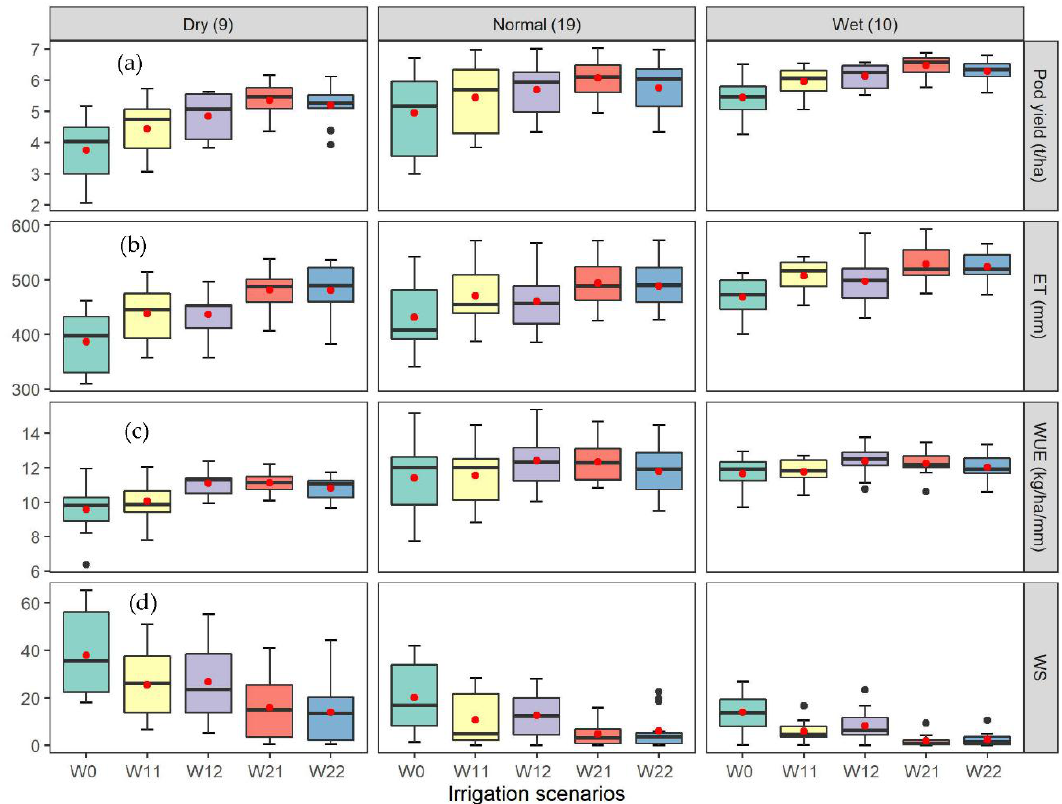
Figure 11. Simulated ranges of peanut ( a ) pod yield, ( b ) evapotranspiration (ET), ( c ) water use efficiency (WUE), and ( d ) water stress (WS) days under different irrigation scenarios, i.e., W0 (rainfed), W11 (60 mm depth before planting), W12 (60 mm depth at flowering), W21 (60 mm depth before planting and 60 mm depth at flowering), and W22 (60 mm depth before planting and 60 mm depth at pod set). The numbers displayed in parentheses are categorized for precipitation years. The box plots show the 25%, 50%, and 75% percentiles and the caps indicate the 5th and 95th percentiles, with the average shown by a red point. The black points are outliers.